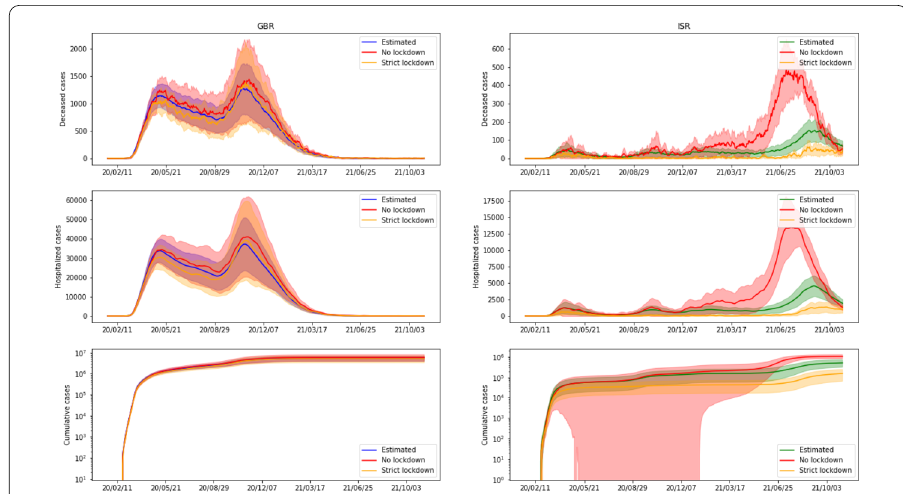
Figure 9 Scenarios(4,5) . Comparison between milder relaxations on restriction policies, confronted with the real ones. Scenario4 , labeled ‘No lockdown’, considers closing of schools and workplaces, but absence of stay-at-home policy. All other measures remain unaltered. Scenario5 , labeled ‘Strict lockdown’, considers that whenever a lockdown is in place, schools and workplaces are also closed, but than no limitations on schools and work attendance are imposed when stay-at-home policies are not enforced. We present cumulative cases, hospitalized and deceased for both GBR (on the left) and ISR (on the